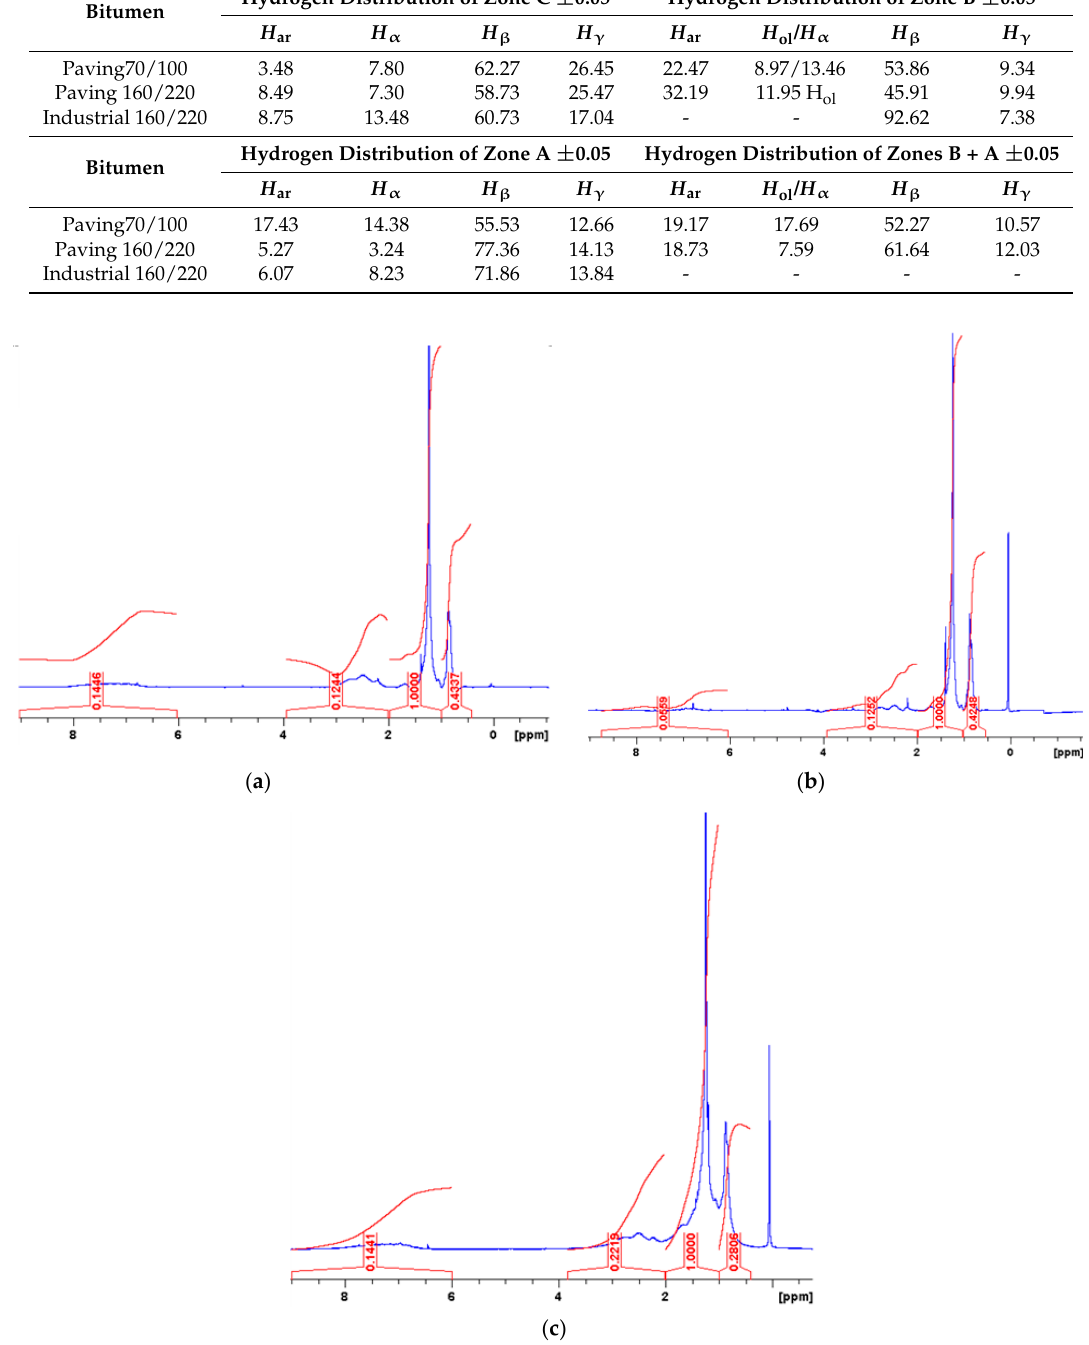
Table 5. Fractional proton distribution of various zones scratched from the three bitumens by preparative TLC obtained from the 1 H-NMR spectra reported in Figures 7–9.